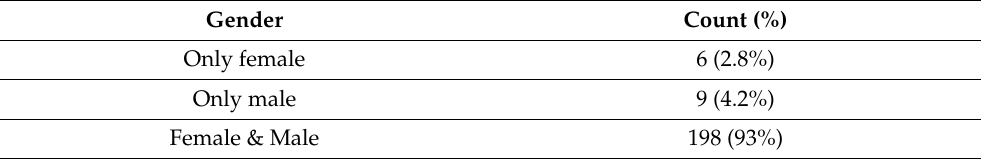
Table 3. Genders Distribution Included in the Studies ( n = 213).